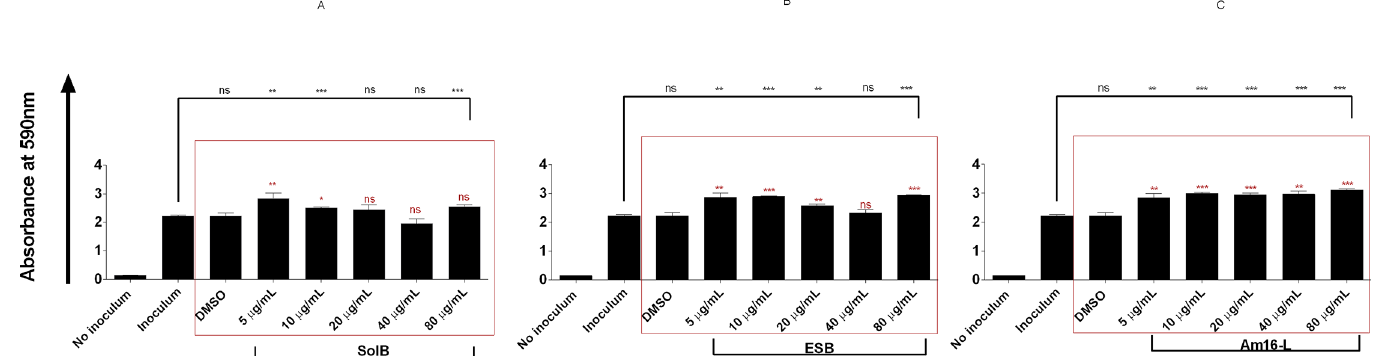
Fig 5. Solonamides marginally enhance biofilm formation of WT strain 8325 – 4. A dilution series of an 8325 – 4 culture were inoculated (5 μ L) into wells of a 96-well microtiter plate containing 200 μ L TSB. SolB (A), ESB (C) or Am16-L (C) was added to final concentrations of 5, 10, 20, 40, and 80 μ g/mL. Inoculum alone, DMSO and no inoculum were used as controls. Biofilm formation was assessed by crystal violet staining and OD590 nm measurement. Each bar represents the average of 3 experiments, and the error bars represent the standard deviation. For statistical significance, comparisons were made between untreated versus vehicle and treated (black bracket), and between vehicle control versus compound treated (red square). ns (no significance); * , p < 0.05; ** , p < 0.01; *** , p < 0.001.